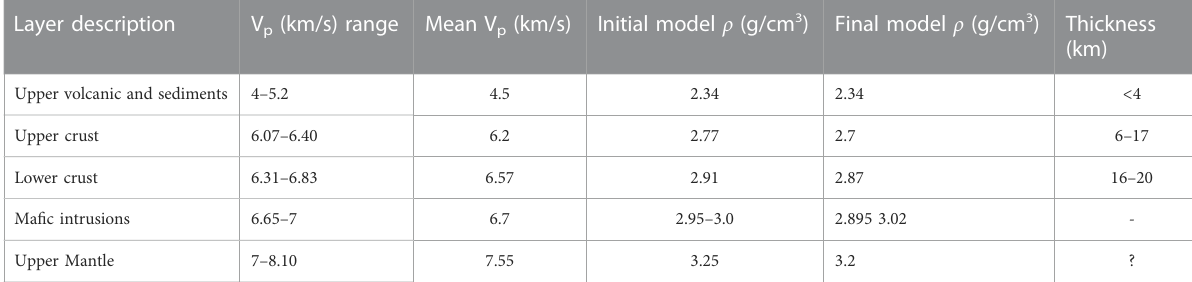
TABLE 1 P-wave velocities (V p ) (Maguire et al., 2006), densities ( ρ ), and thickness of each body in the gravity modeling. Layer